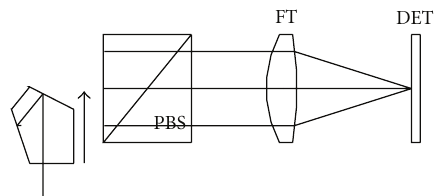
Figure 7: Method of measuringsystematic slope error caused by the BLM for the LTP MF: an external pencil beam is scanned laterally over the LTP MF aperture by a pentaprism. If there is no systematic slope error, the slope curve should be a straight line.